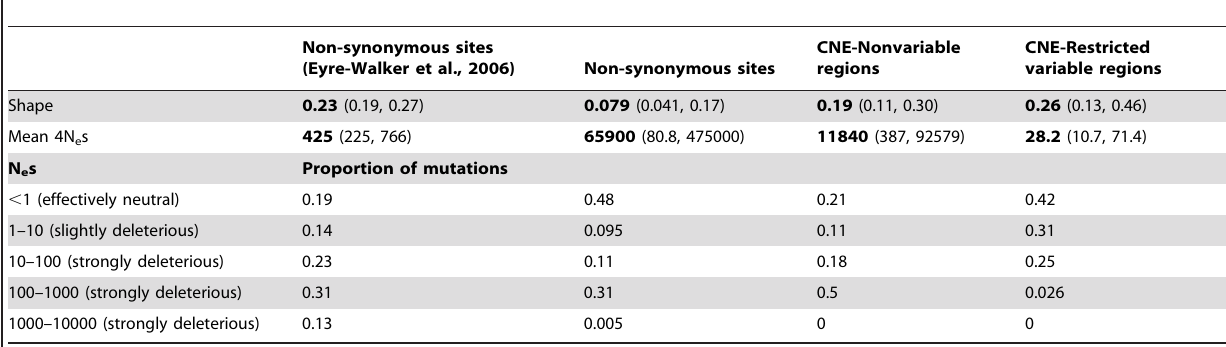
Table 4. Distribution of selective effects as inferred by the method of Eyre-Walker et. al, 2006.